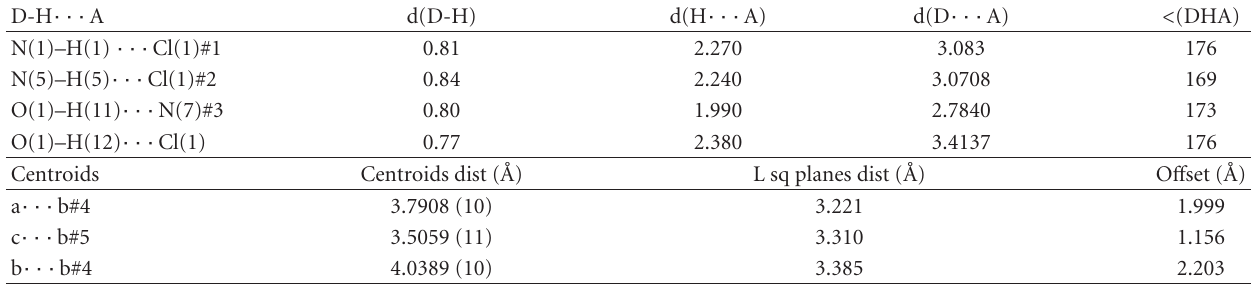
Table 3: Hydrogen bonding and stacking interactions in 1